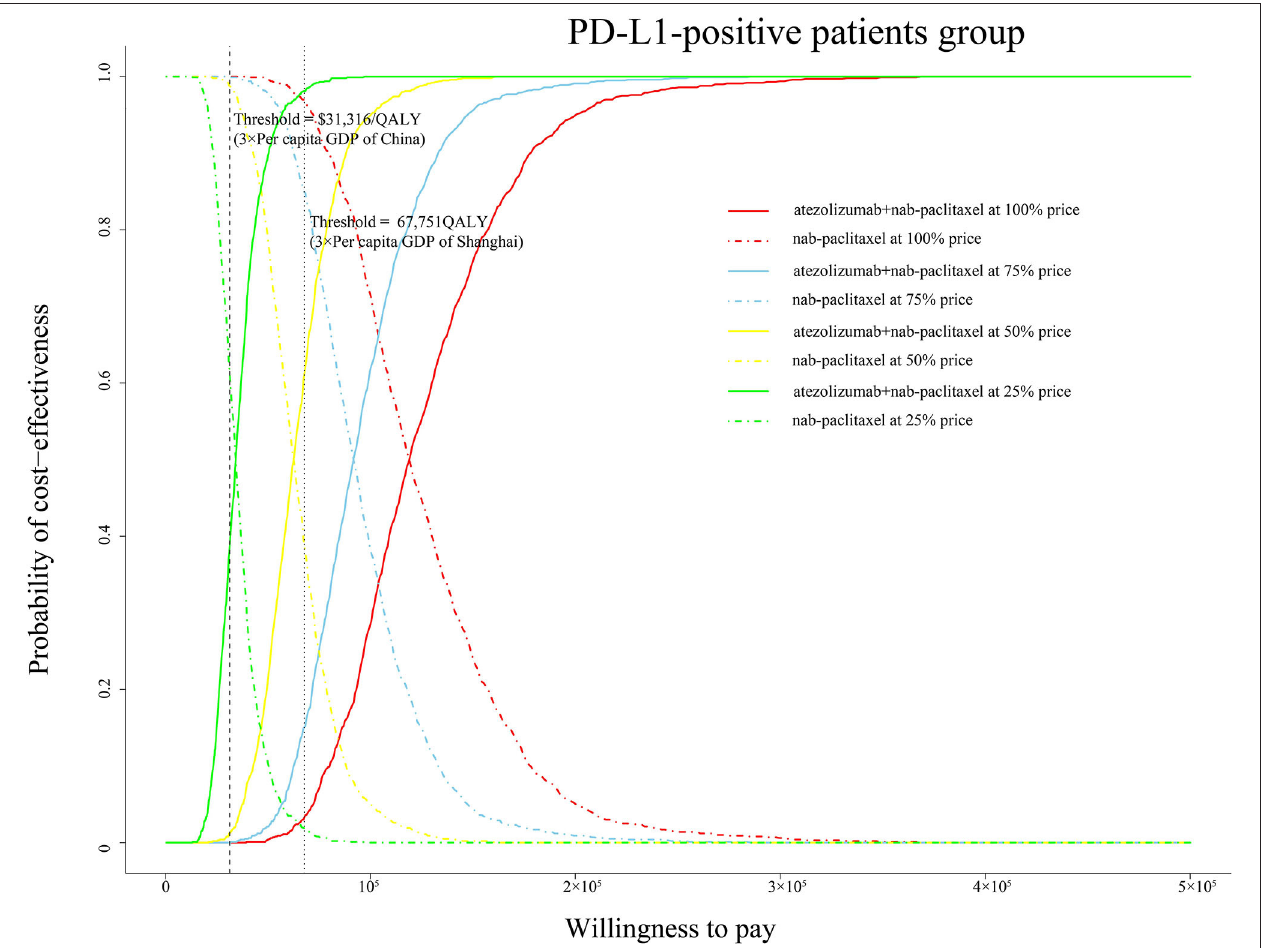
FIGURE 4 | Cost-effectiveness acceptable curve. The y-axis indicates the probability that a regimen is cost-effective across the willingness-to-pay threshold (x-axis). QALY, quality-adjusted life-year; PD-L1, programmed death ligand-1; GDP, gross domestic product.